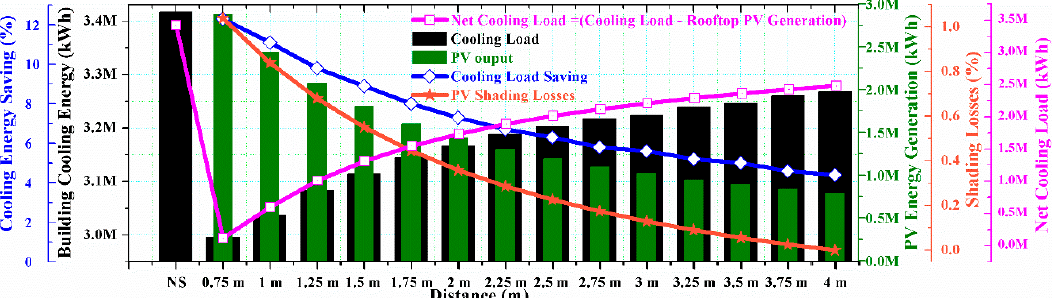
Figure 9. Comparison between the saving in cooling load of building with the self-shading of PV arrays by placing them at a various distance on building rooftop, and the net energy required to maintain the temperature in the building by using rooftop PV energy generation.